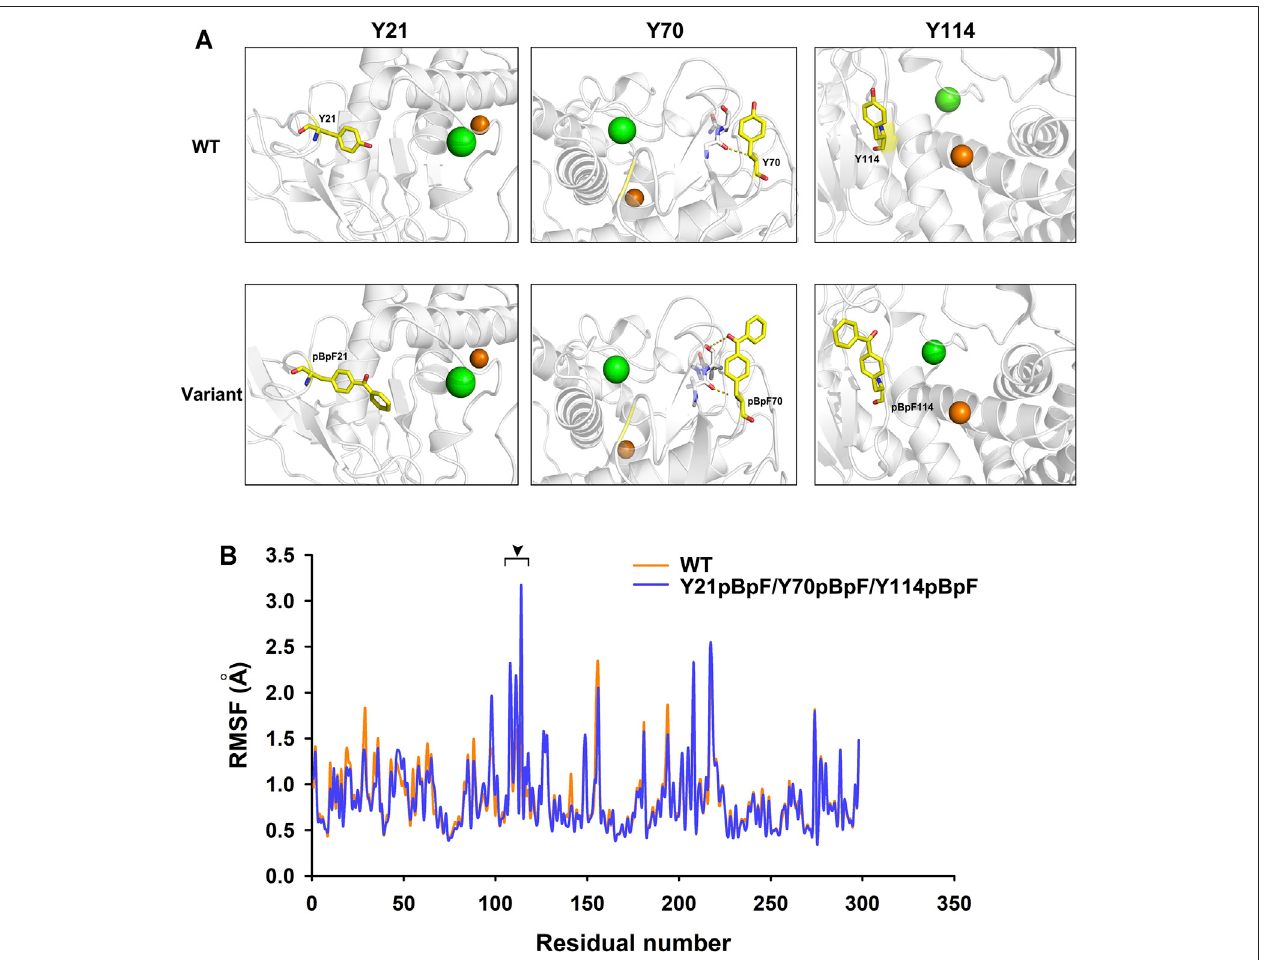
FIGURE 7 | Structure and molecular dynamics analysis of local region of wild-type (WT) enzyme and its variants. (A) Local structures of WT and its variant. Green andorangeballsinproteinstructurerepresentboundcalciumandzincions,respectively.Mutantresiduesareshownasyellowsticks.Dottedlinesrepresentinteractions formed by original and substituted residues in WT enzyme and variants. (B) Residual root mean square fl uctuation (RMSF) ofkeratinase from Pseudomonas aeruginosa (KerPA) and its variant. Black arrowhead indicates regions with increased residual fl exibility in variant.